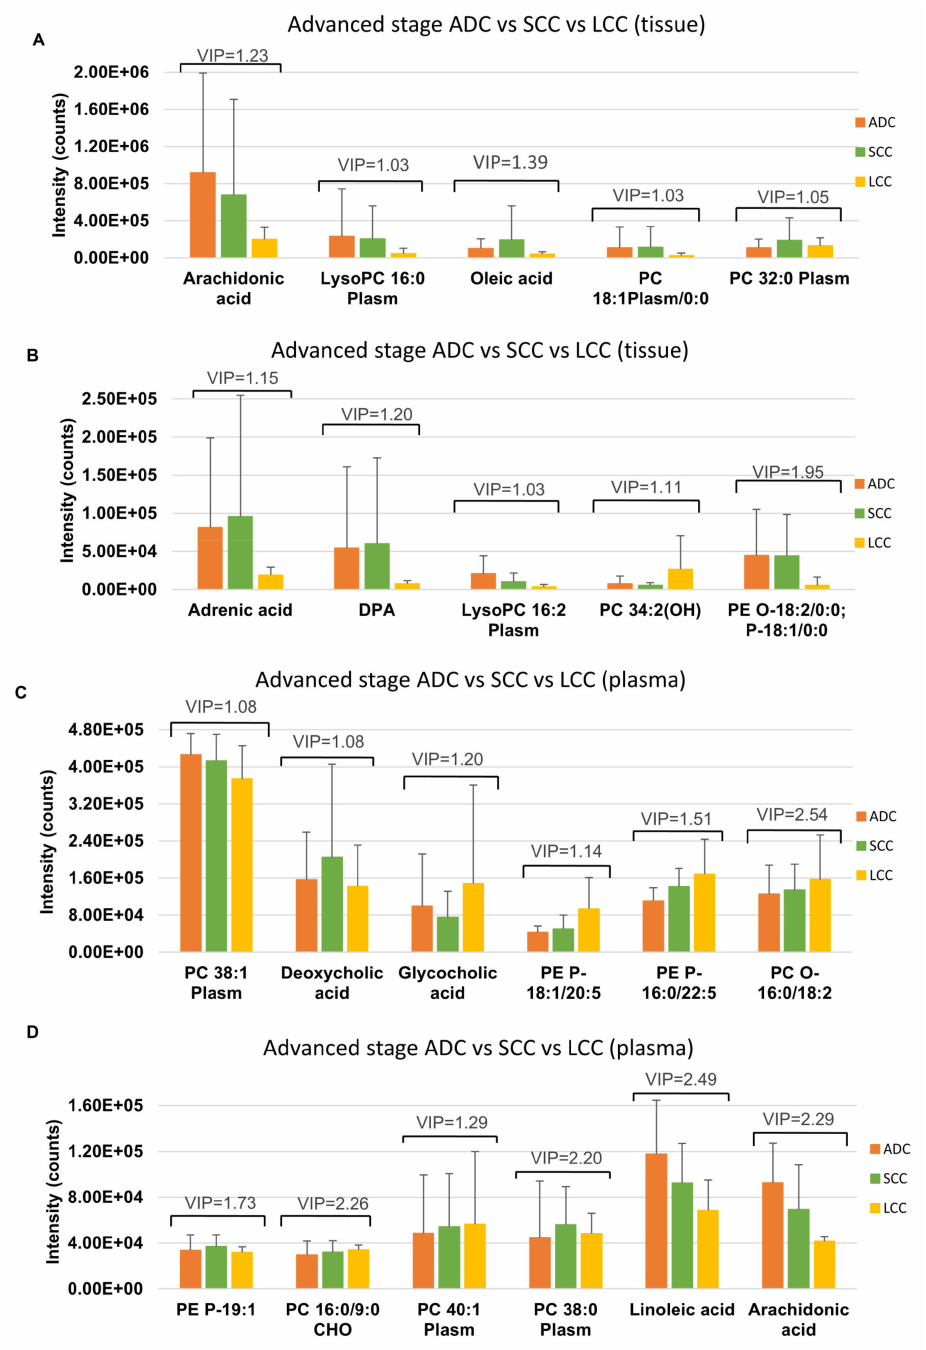
Figure 6. Metabolites that differentiate the advanced stages of SCC, ADC and LCC in tissue and plasma samples. Panels ( A , B ) show the intensity of selected identified tissue metabolites that differentiate the three subtypes in the advanced stage. Panels ( C , D ) show the intensity of selected identified plasma metabolites that differentiate the three subtypes in the advanced